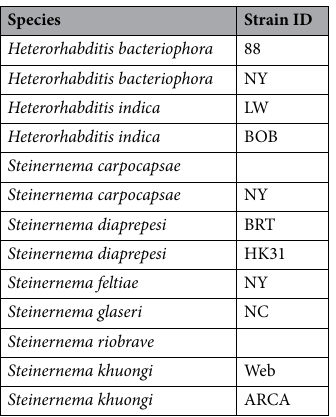
Table 1. The thirteen strains of entomopathogenic nematodes used in this trial. Note that Steinernema khuongi is a relatively newly identified Steinernema species 34